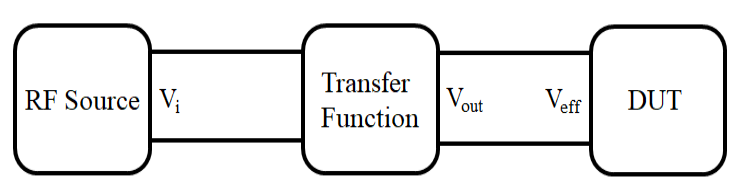
Figure 2. Schematic of the voltage transfer function.